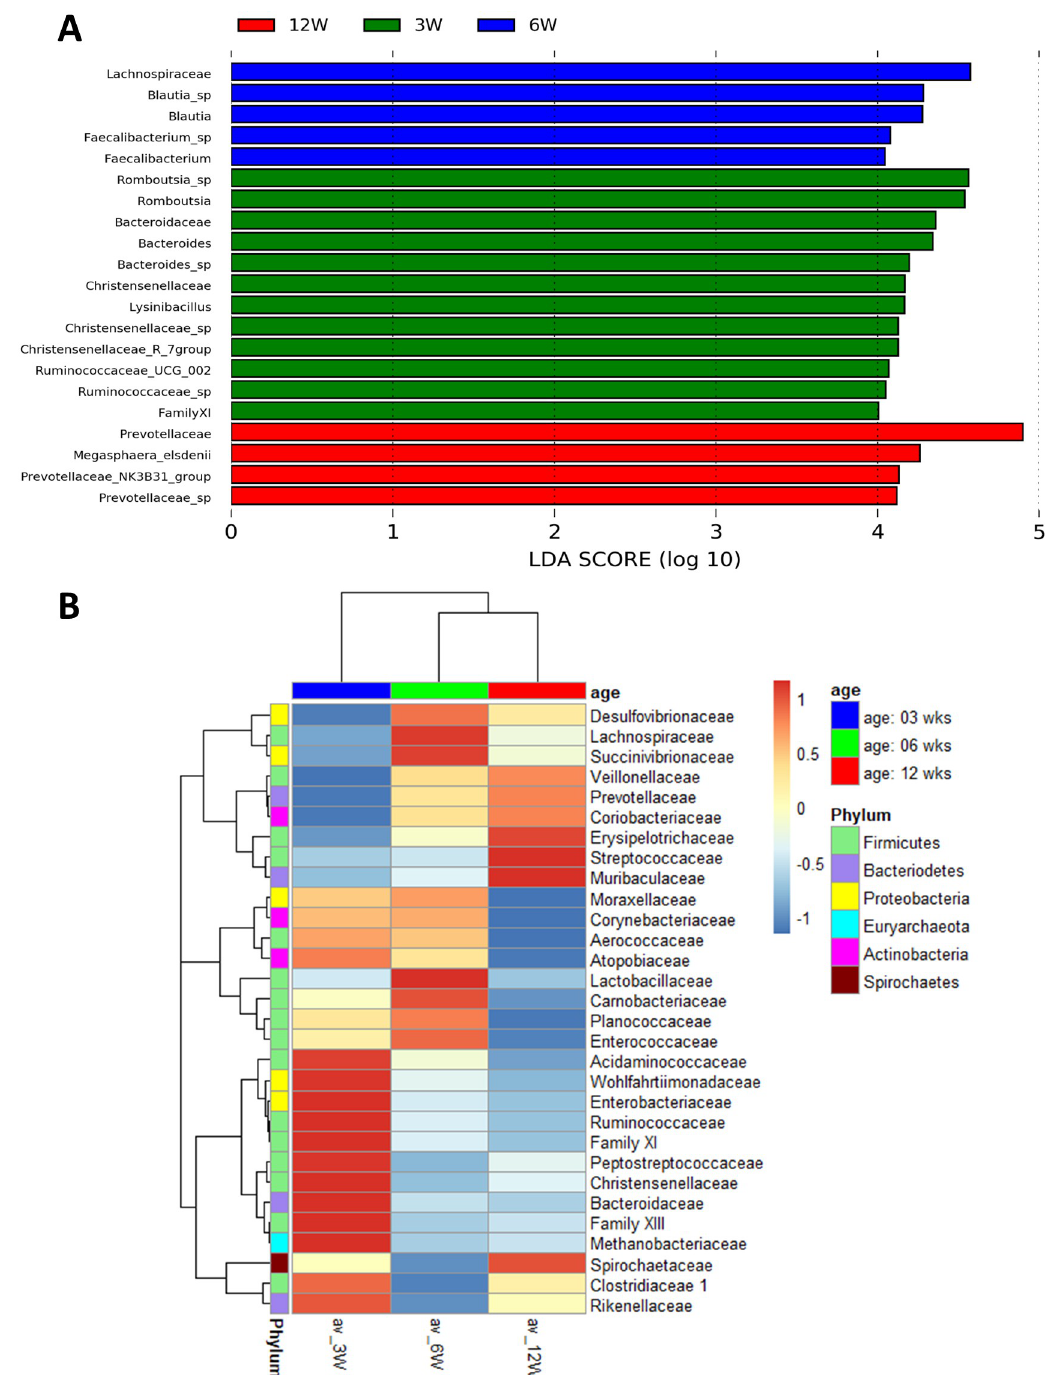
Fig 2. Differentially abundant taxa among sampling times. For the analysis of age dependent change the data of all treatments per age was merged. ( A ) Histogram of the results of LEfSe among 3, 6, and 12 weeks-age and their respective effect size; P values < 0.05 considered significant. ( B ) Heatmap of the 30 most abundant families of bacteria at different ages. The color scale shows the Z-score of abundance of families within each group.